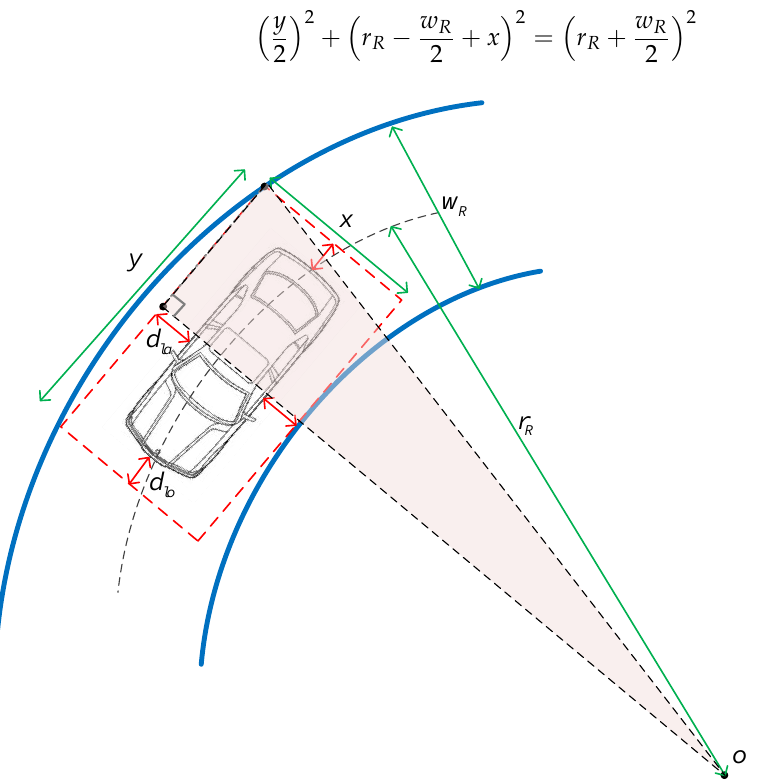
Figure 2. Geometric relationship between vehicle size and road.